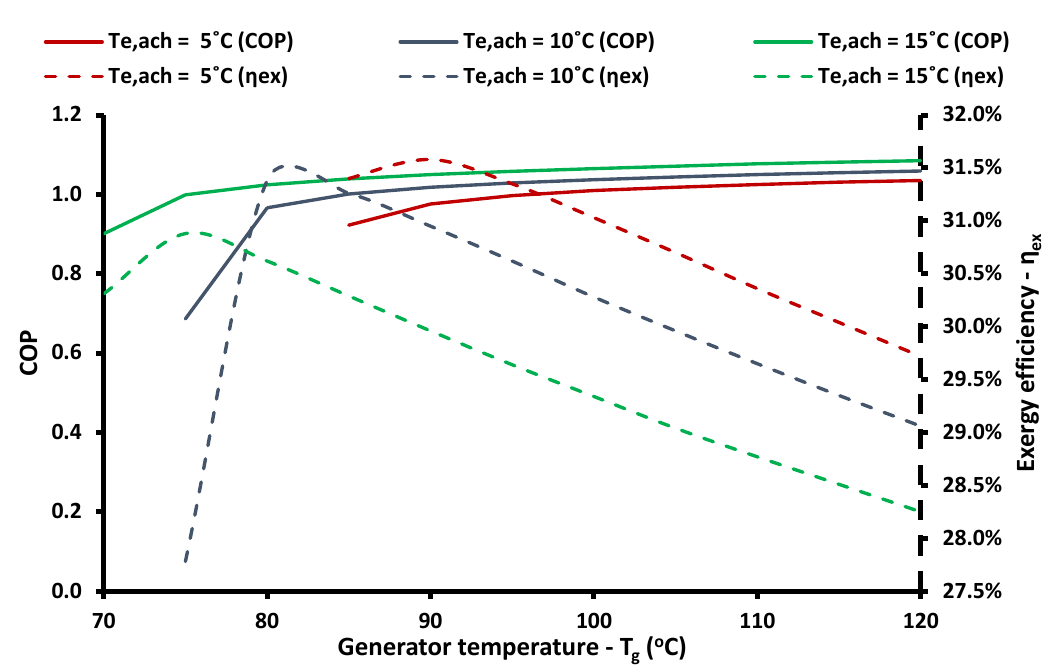
Figure 14. COP and exergy efficiency of the absorption chiller subcooling system for different pressure ratio parameters and generator temperature levels with (T e,ach = 10 °C, T e = − 15 °C, and T c = 40 °C).